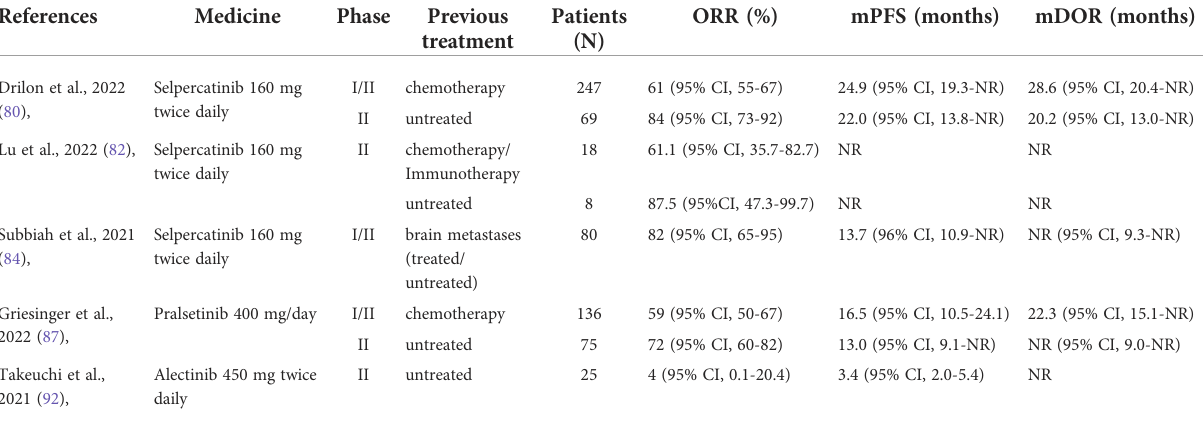
TABLE 4 Selective inhibitors in RET+NSCLC